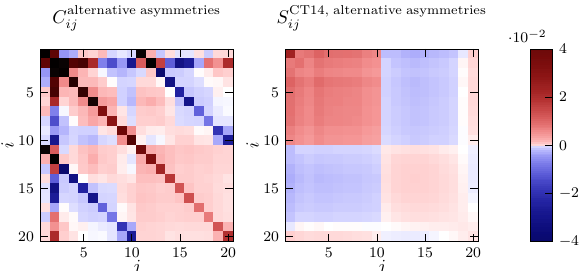
Fig. 13 As Fig. 2, but now for the alternative asymmetries shown in Fig. 12. Note that here we do not normalize by the data values as they can be smaller than the uncertainties in ˜ A pPb . The scale of the heat map is thus different from the other figures. Indices i , j follow the same ordering as the data points in Fig. 12, with the indices 1 through 10 corresponding to ˜ A pPb and 11 through 20 to A ∗ pPb